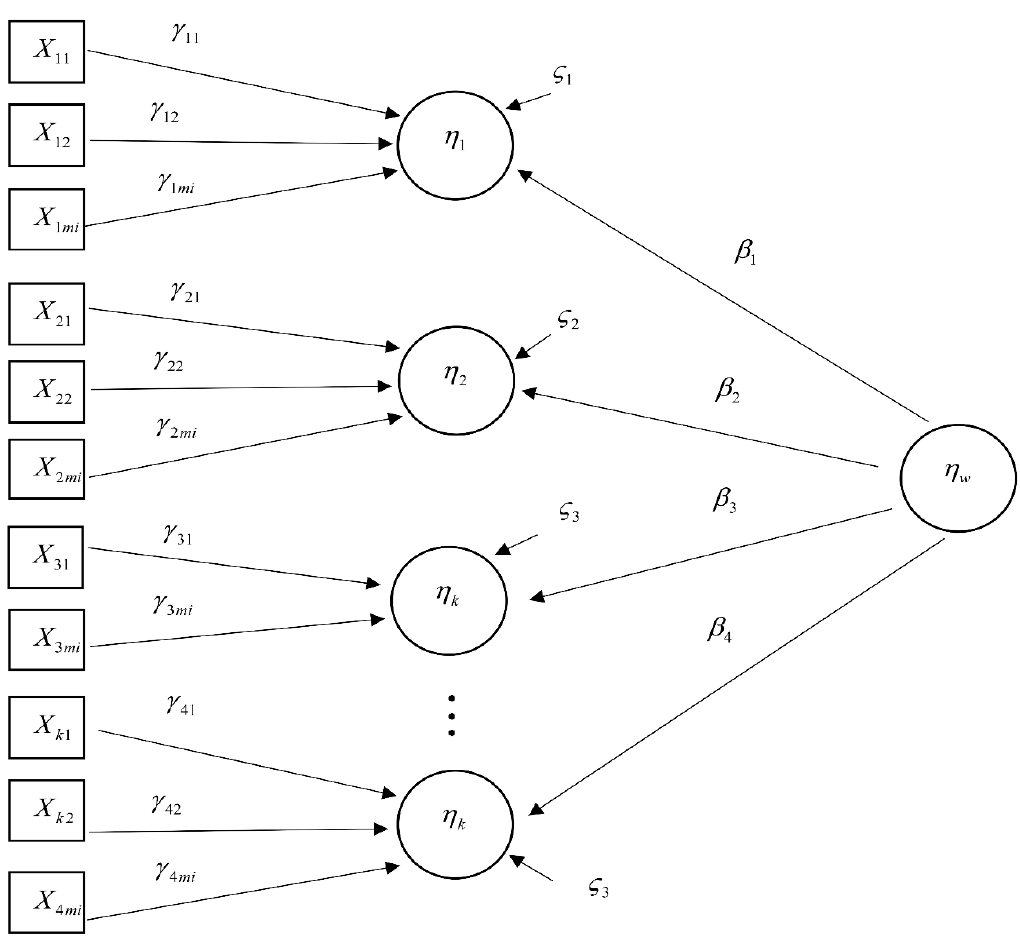
Figure 5. The variance on dimension variable only.